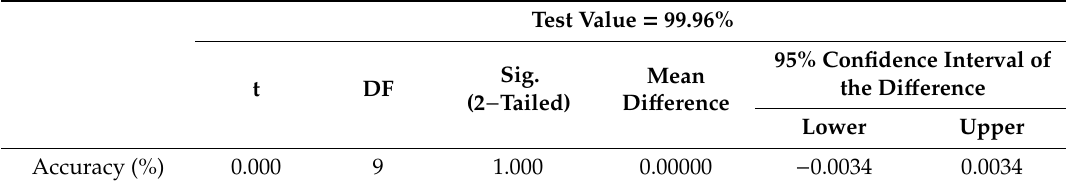
Table 14. One-sample t-test results for the accuracy of attack and benign classification using a 10-fold cross-validation technique.